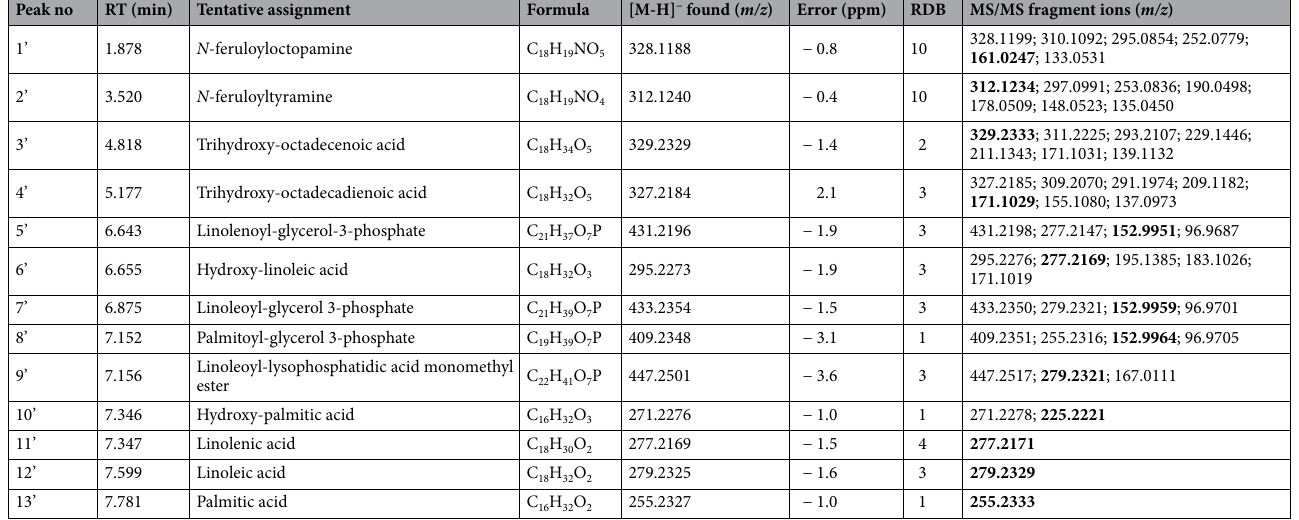
Table 3. UHPLC-ESI-QqToF/MS and MS/MS data useful for metabolite tentative identification in lipophilic extracts (base peaks in MS/MS spectra are reported in bold; RT = retention time; RDB = ring and double bond value). MS/MS spectra are reported as Supplementary